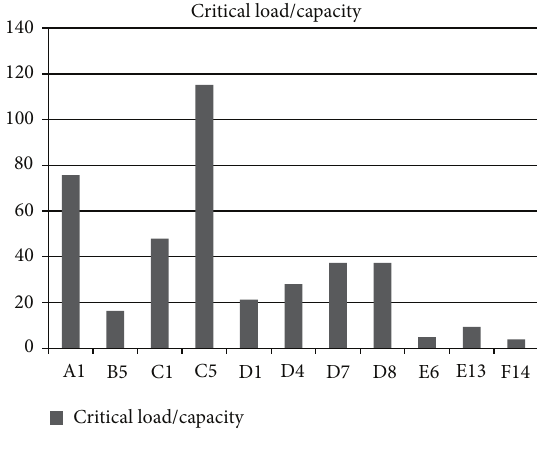
Figure 9: Ratios of critical loads and